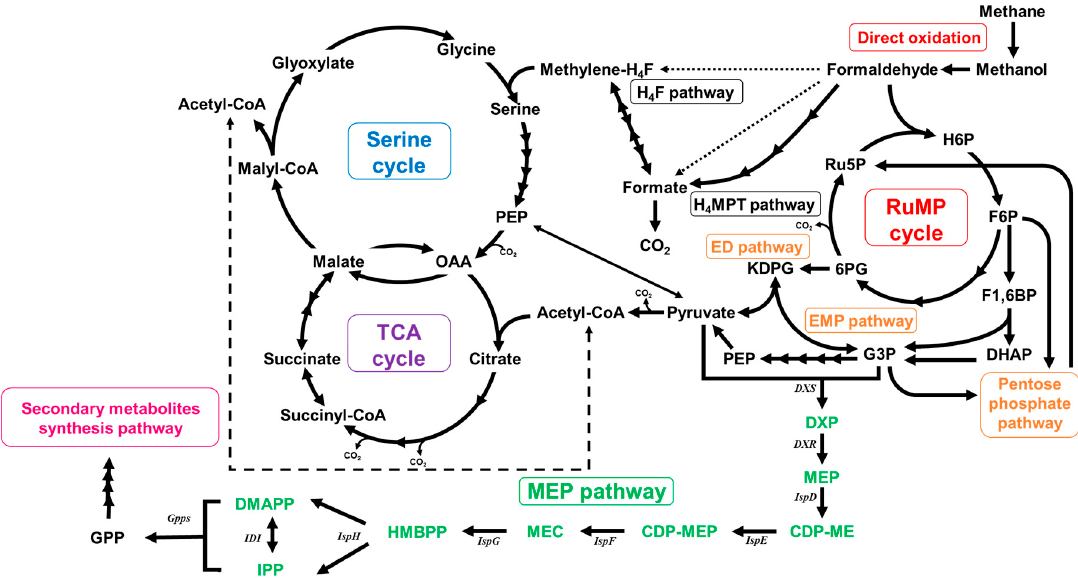
Figure 4. The proposed metabolic pathway of C1 assimilation and the secondary metabolites